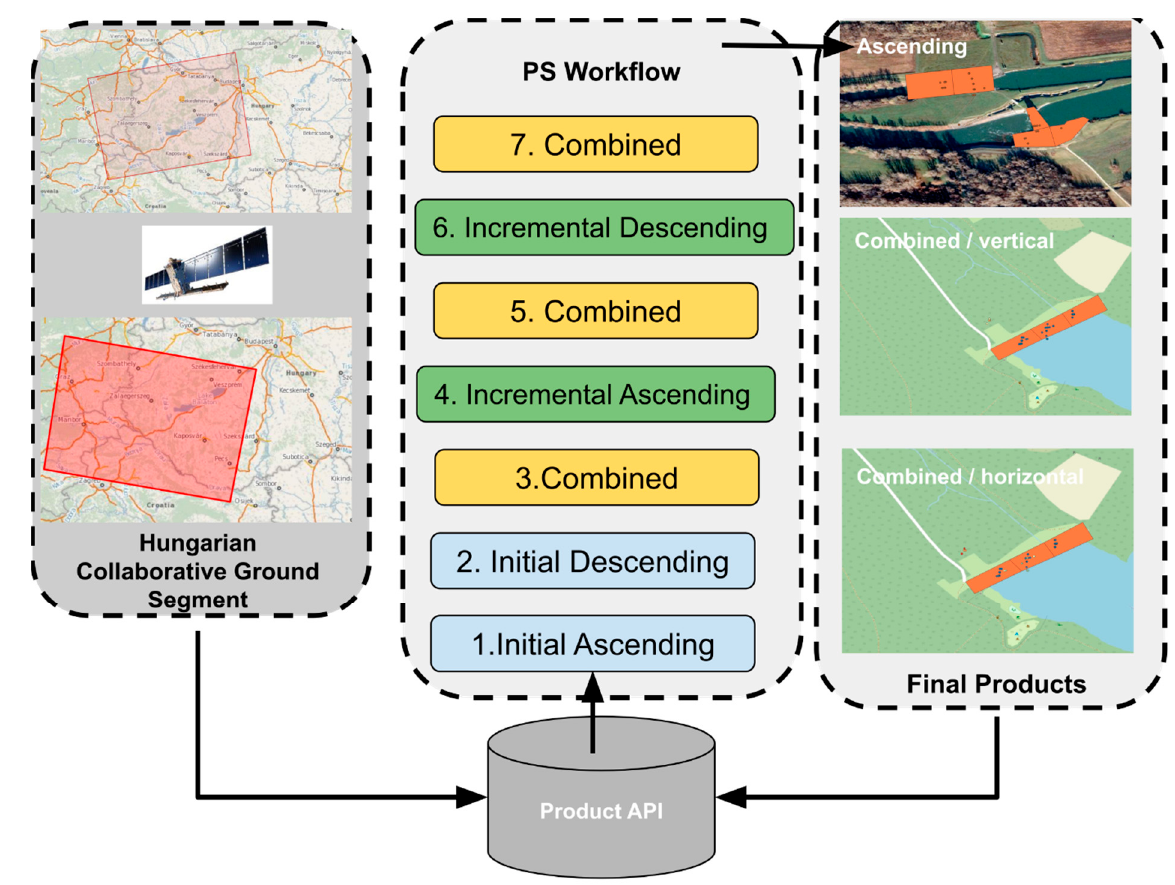
Figure 9. General scheme of the S1 data processing methods.